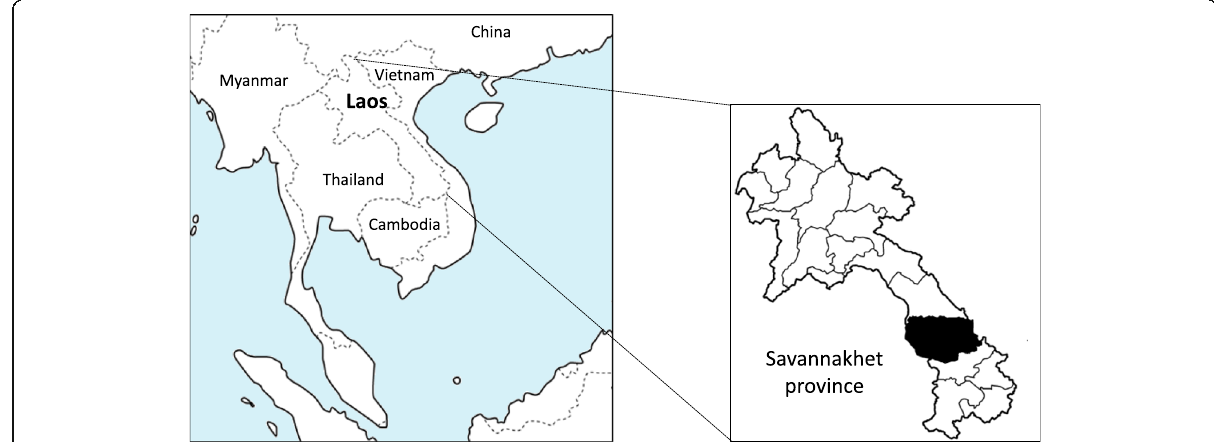
Fig. 1 Location of Savannakhet Province (black) in